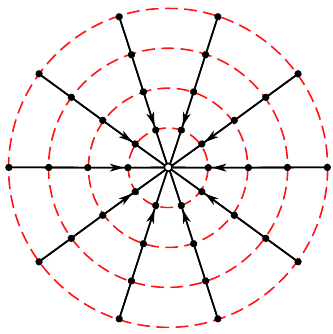
Figure 1 . The \wheel" Feynman graph with M frames de(cid:12)ning the order (cid:24) 2 MJ of the perturbative expansion of anomalous dimension of the BMN vacuum operator Tr (cid:30) J